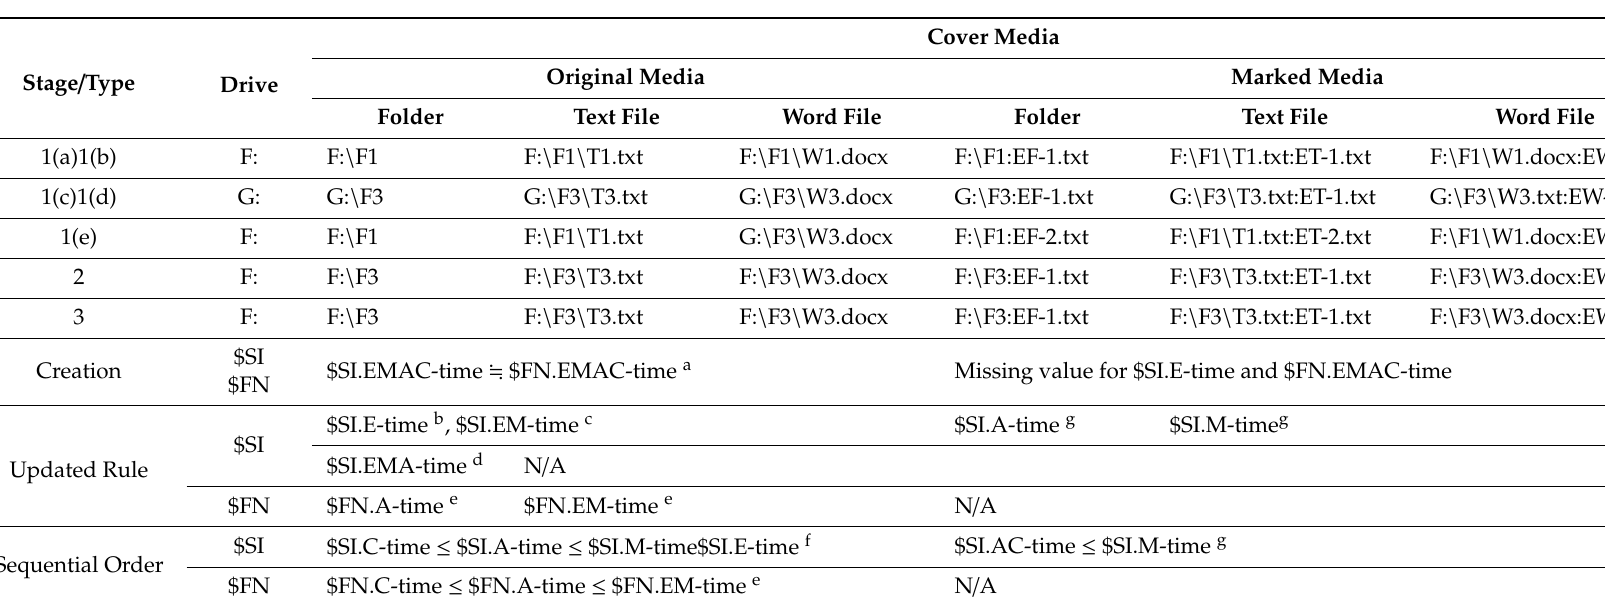
Table 10. Relational reconstruction on the timestamp observation of cover